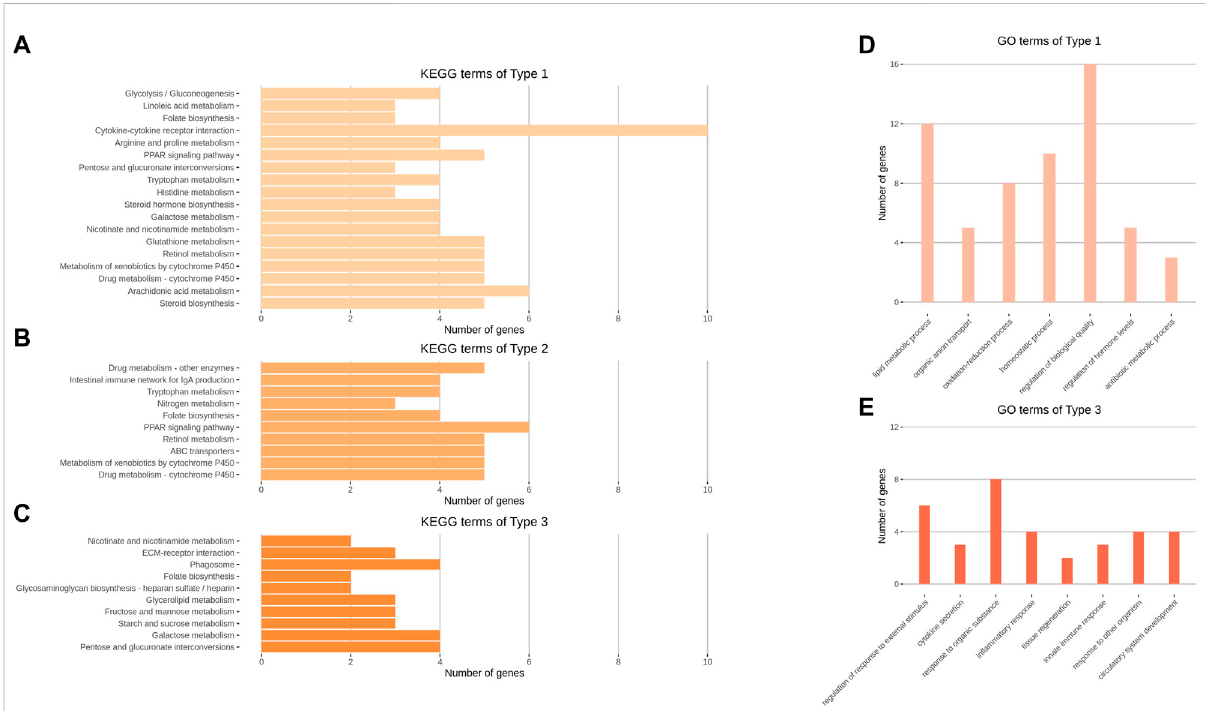
FIGURE 4 KEGG and GO analysis results of Type 1, 2, and 3 gene clusters. (A – C) Enriched KEGG pathways of Type 1, 2, and 3 genes clustered using the k-means clustering method. (D – E) Enriched GO terms of the biological process category of Types 1 and 3 gene clusters. Representative GO terms wereselectedfrom53to188signi fi canttermsofTypes1and3,respectively.GOanalysisofType2genesdidnotshowanysigni fi cantterms. (A – E) All enrichment terms passed a signi fi cance cut-off ( p < 0.05) and were sorted in the order of largest signi fi cance